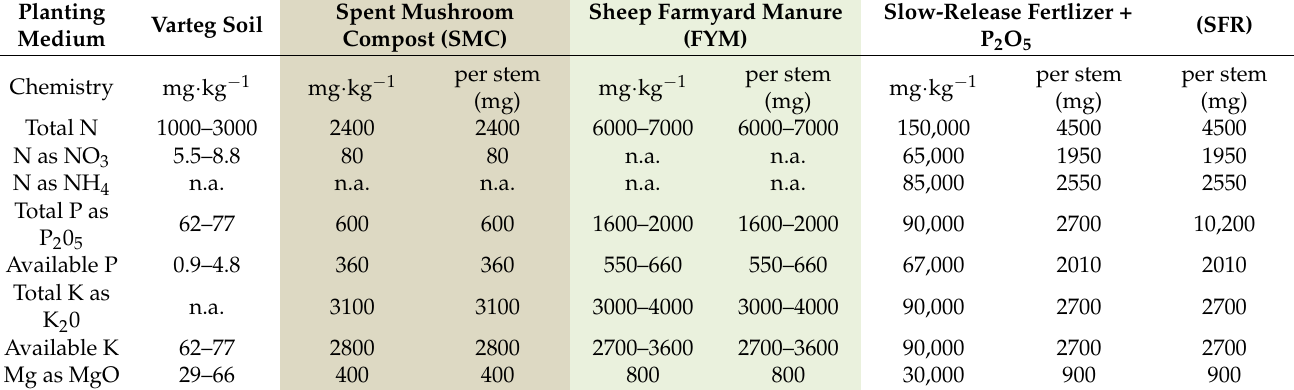
Table 2. Chemical composition of planting media, fertilizer supplements and